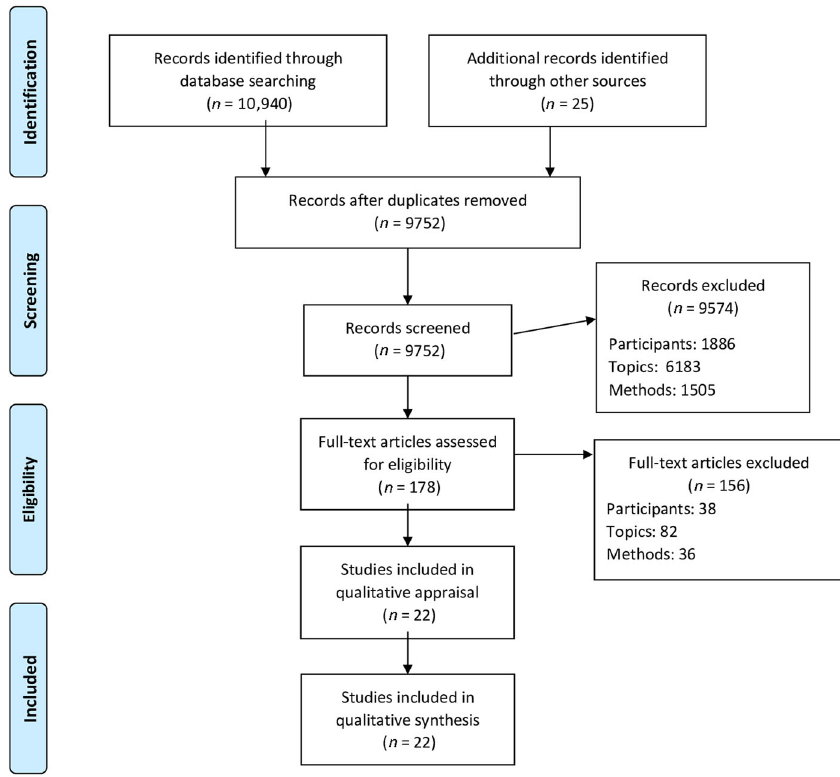
Fig. 1 Flow of information through the different phases of the study selection. From: Moher, D., Liberati, A., Tetzlaff, J. & Altman, D. G. The PRISMA Group. Preferred Reporting Items for Systematic Reviews and Meta-Analyses: The PRISMA Statement. PLoS Med. 6(6), e1000097